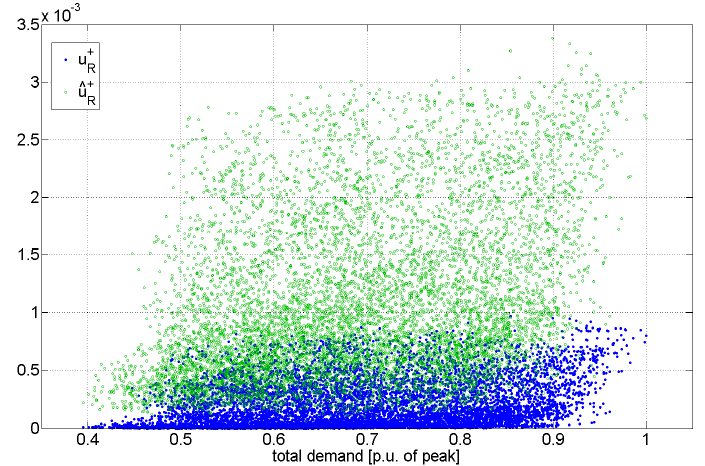
Figure 7. Distribution of N and N − 1 network overload indices with respect to total demand.